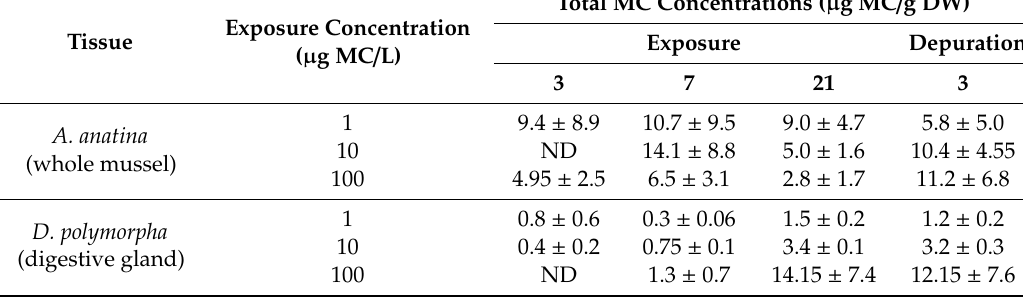
Table 1. Total MC concentrations (µg MC/g DW) in whole A. anatina and digestive glands of D. polymorpha at days 3, 7 and 21 of exposure and day three of depuration in mussels exposed to a density of P. agardhii producing an equivalent of 1, 10 and 100 µg MC/L. Data not shown due to technical difficulties are referred as ND (Not Determined).